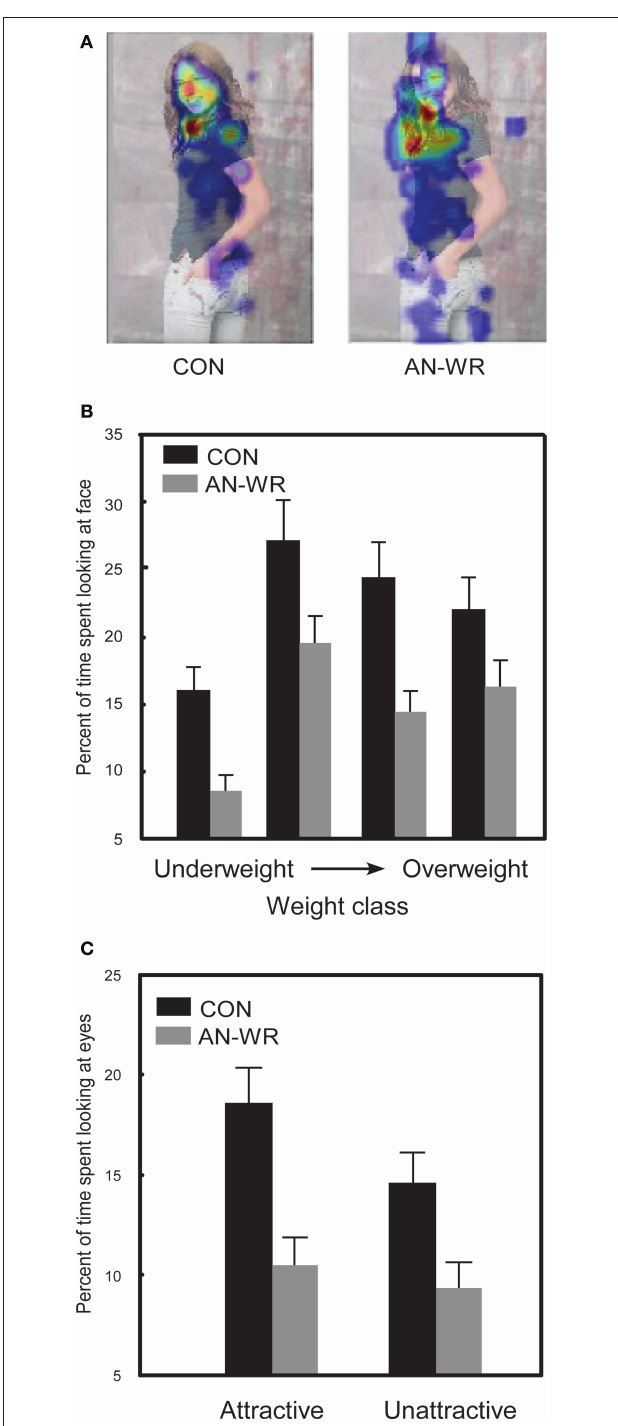
Figure 3 | Disruptions in social attention in anorexia nervosa. (A) Mean eye dwell times on an example body image for all control participants (left, CON) and for all weight-restored participants with anorexia (right, AN-WR). Hot colors correspond to longer looking times (see Methods). (B) Participants with anorexia nervosa (gray) spent less time than control females (black) looking at the face regions of female full body images. Note that both participant groups spent less time looking at the faces of underweight individuals. (C) Participants with anorexia nervosa (gray) spent less time than control females (black) looking in the eye region of female face